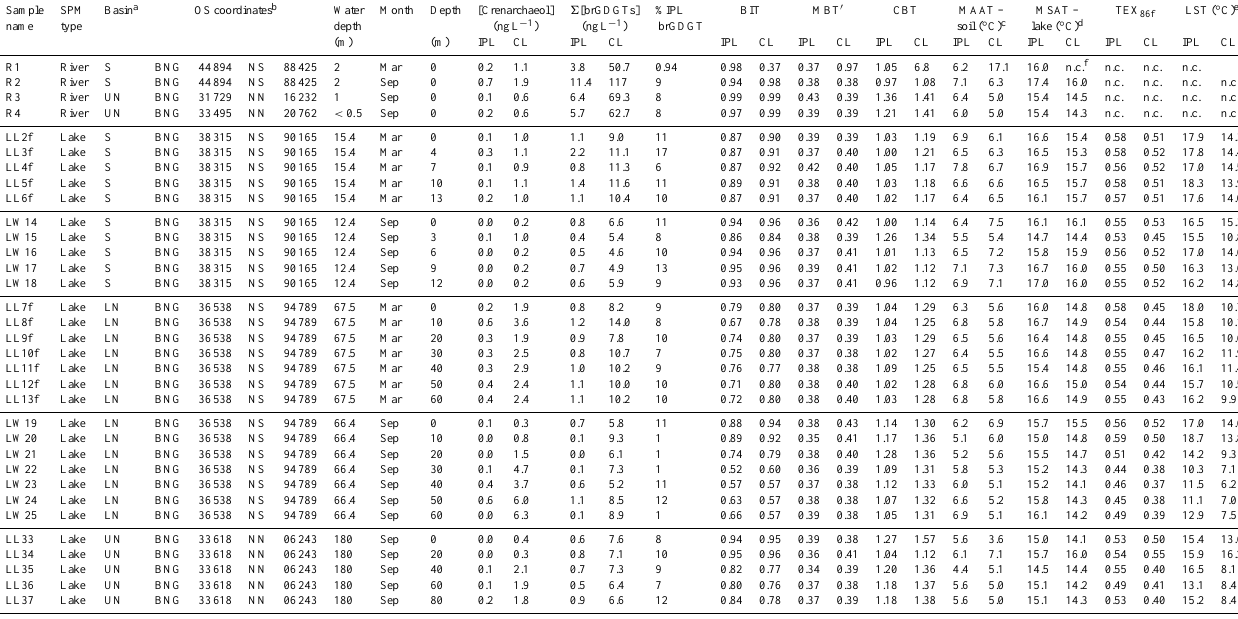
Table 2. Suspended particulate matter (SPM) from river and lake water: crenarchaeol and summed brGDGT concentrations, MBT 0 indices, CBT ratios, BIT indices, TEX 86 indices, inferred mean annual air temperatures (MAATs), inferred mean summer air temperatures (MSATs) and inferred lake surface temperatures (LSTs).